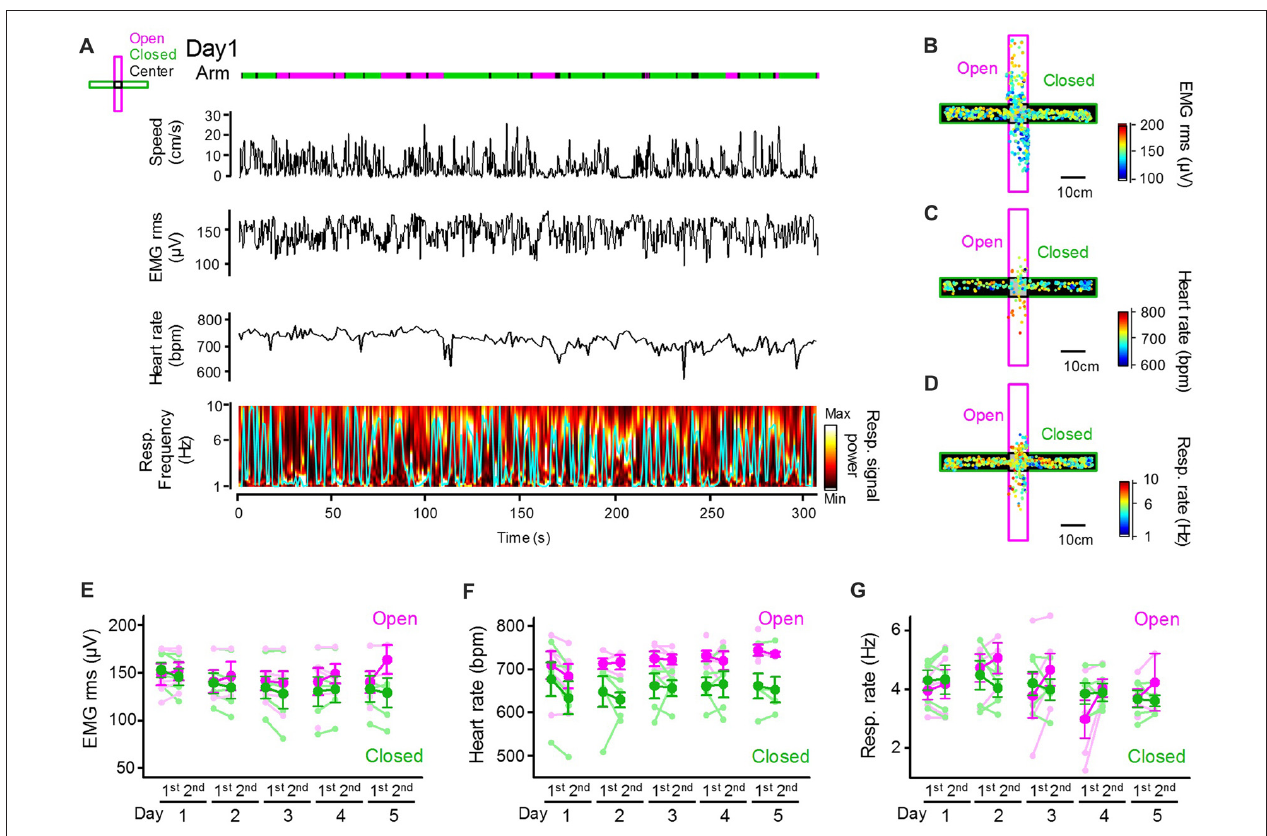
FIGURE 2 | Peripheral physiological signals during the EPM test. (A) Representative animal’s running speed, root mean square (RMS) of an EMG signal, heart rates and color-coded power spectrum of a respiratory signal with the frequency giving the maximum power indicated by the cyan line. Periods when the animal was located in open and closed arms and the center are represented in magenta, green and black lines, respectively. (B–D) Color-coded animal’s trajectory shown by dots. The color codes represent the RMS of EMG signals (B) , heart rates (C) and respiratory rates (D) corresponding with an individual animal’s locations. (E–G) Average RMS of EMG signals, heart rates and respiratory rates plotted for open and closed arms in individual sessions. The statistical results in these figures are described in the main text.